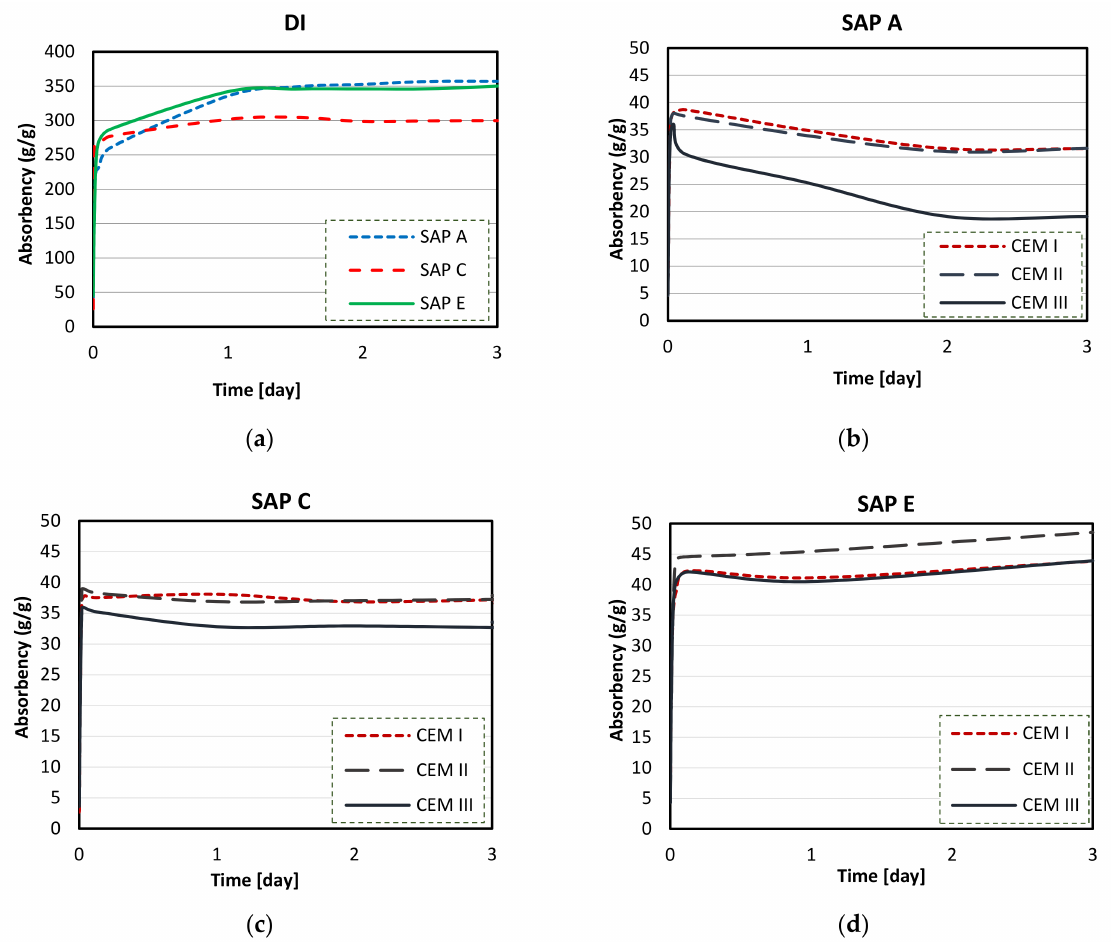
Figure 16. Sorption behaviour of SAPs in different solutions up to 3 days: ( a ) DI water, ( b ) CEM I (PC), ( c ) CEM II (PC-FA), and ( d ) CEM III